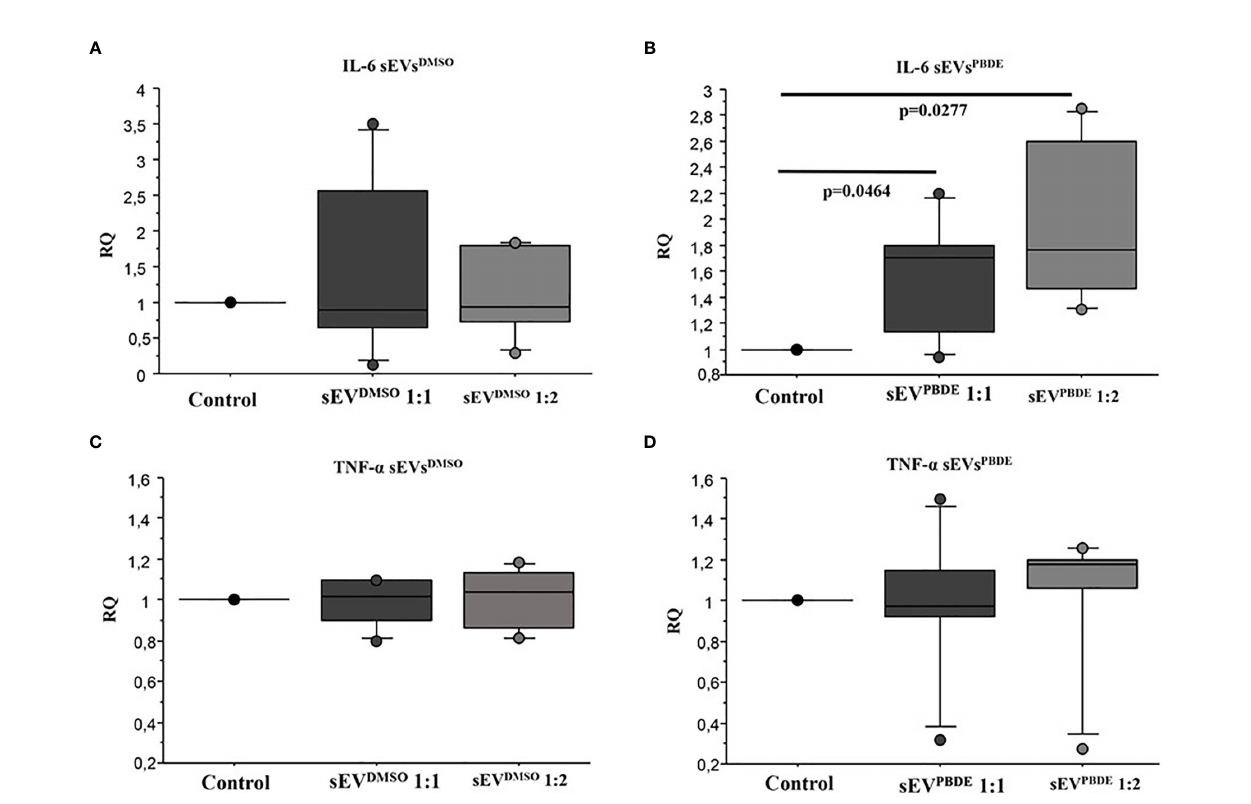
FIGURE 6 | Real Time analysis of IL-6 and TNF- a cytokines in naïve M(LPS) THP-1 macrophages treated with sEVs. The effect of sEVs DMSO on M(LPS) THP-1 macrophages (A, C) is comparable to control cells (treatment with LPS). Conversely, the two different concentrations of sEVs PBDE (B) induce a statistically signi fi cant increase in IL-6 expression (p = 0.046 and p = 0.027, respectively); no signi fi cant change in TNF- a expression (D) was observed for both sEVs PBDE concentrations used in the treatment assays. Boxplot bars indicate (from the bottom to the top) 10 th , 25 th , 50 th (median), 75 th , and 90 th percentiles. Values below the 10 th and above the 90 th percentiles are plotted as circles. Statistical analysis was performed by Wilcoxon signed rank test used for evaluating not normally distributed paired